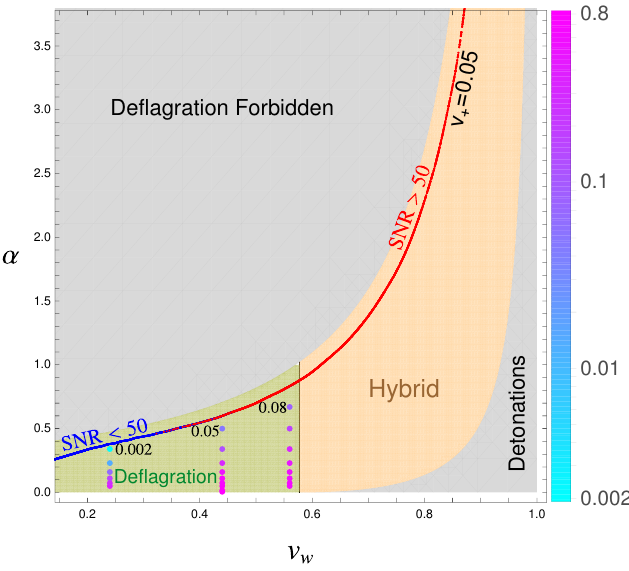
Figure 2 . This (cid:12)gure shows the normalized energy released from the EWPT (cid:11) versus the bubble wall velocity v w . The gray region in the top left is theoretically inaccessible and the gray region in the bottom right gives a detonation (cid:13)uid pro(cid:12)le which fails EWBG. The green region gives de(cid:13)agration mode and the brown region gives hybrid mode. All ( v w , (cid:11) ) on the curve labelled v + = 0 : 05 give a plasma relative velocity 0.05 heading towards the wall from outside the bubble. All the scanned points fall on this curve, with the red (blue) points giving SNR larger (smaller) than 50, which are calculated without including the suppression factor (see the text for the details of the suppression factor). The dots denote the pairs of ( v w , (cid:11) ) for which numerical simulations of GW production are performed in ref. [15], with the color of each point showing the value of the suppression factor of the GW signal as can be read from the color legend. The number close to the top-most point in each of the three columns of points denotes the corresponding suppression factor for that